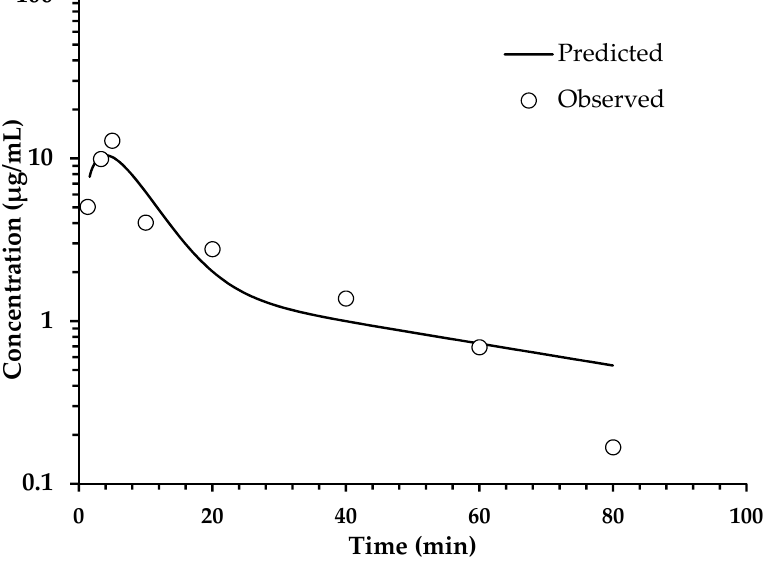
Figure 3. Analysis of variation of the sphaeralcic-acid concentrations in plasma with respect to the time in minutes, after oral administration (400 mg/kg) of the SaTSS standardized fraction. The line represents the prediction of the behavior of the concentration following a two ‐ compartment model.